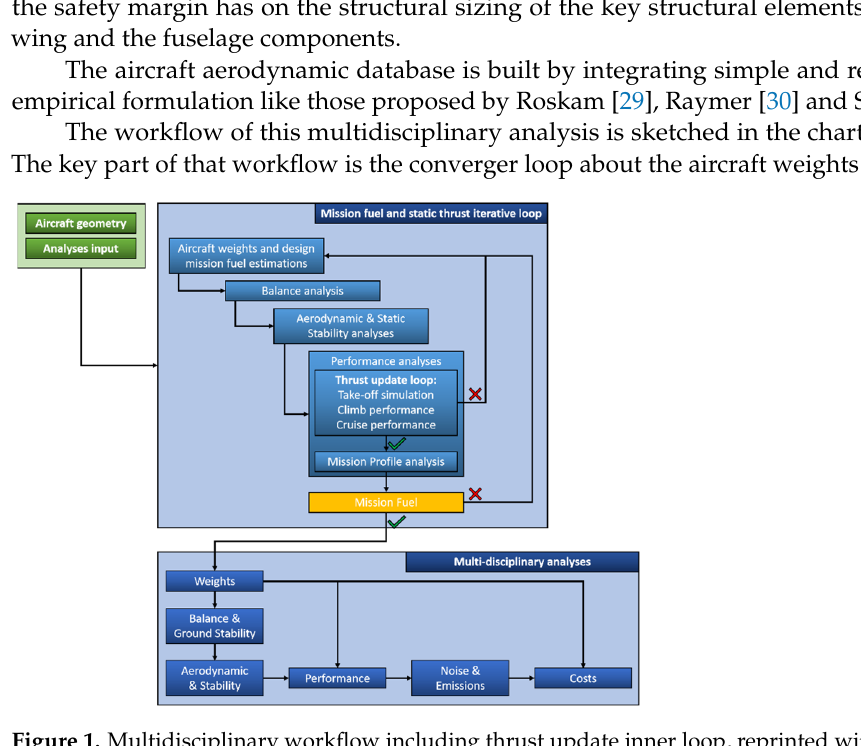
Figure 1. Multidisciplinary workflow including thrust update inner loop, reprinted with permission from [32].